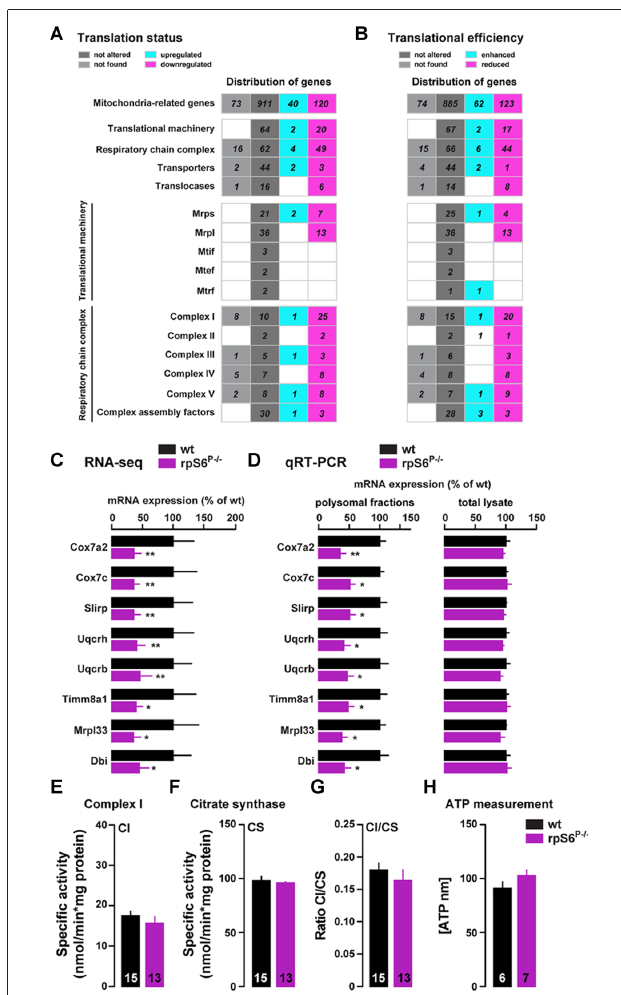
FIGURE 7 | Altered translation of mitochondria-related mRNAs in rpS6 P − / − mice. (A,B) Hierarchical classification of mitochondria-related genes with altered translational status (A) or translational efficiency (B) according to MitoCarta2.0 database. The total number of genes is displayed as upregulated (green gray) or downregulated (magenta) in rpS6 P − / − mice, equally expressed between genotypes (dark gray), or not expressed in the Acb (light gray). (C) Relative mRNA abundance obtained from RNAseq of Acb heavy polysomal fractions between wt (black bars) and rpS6 P − / − mice (magenta bars). (D) Relative mRNA expression obtained by qRT-PCR analysis of heavy polysomal fractions (left) or total lysates (right) of the Acb from wt and rpS6 P − / − mice. The translation efficiency (polysomal association) or abundance of each mRNA was normalized to that of β -actin mRNA. Results are represented as mean ± SEM. ∗ p < 0.05; ∗∗ p < 0.01 by DESeq2 (for RNAseq) and by Student’s t test (for qRT-PCR; n and p values in Supplementary Table S1:7c,d). (E) Enzymatic activity of complex I (CI) in the Acb of wt and rpS6 P − / − mice. (F) Enzymatic activity of citrate synthase (CS) in the Acb of wt and rpS6 P − / − mice. (G) Ratio CI/CS in the Acb of wt and rpS6 P − / − mice. (H) ATP levels in the Acb of wt and rpS6 P − / − mice. The number of animals in each condition is indicated in the bars. Results are represented as mean ± SEM ( n and p values in Supplementary Table